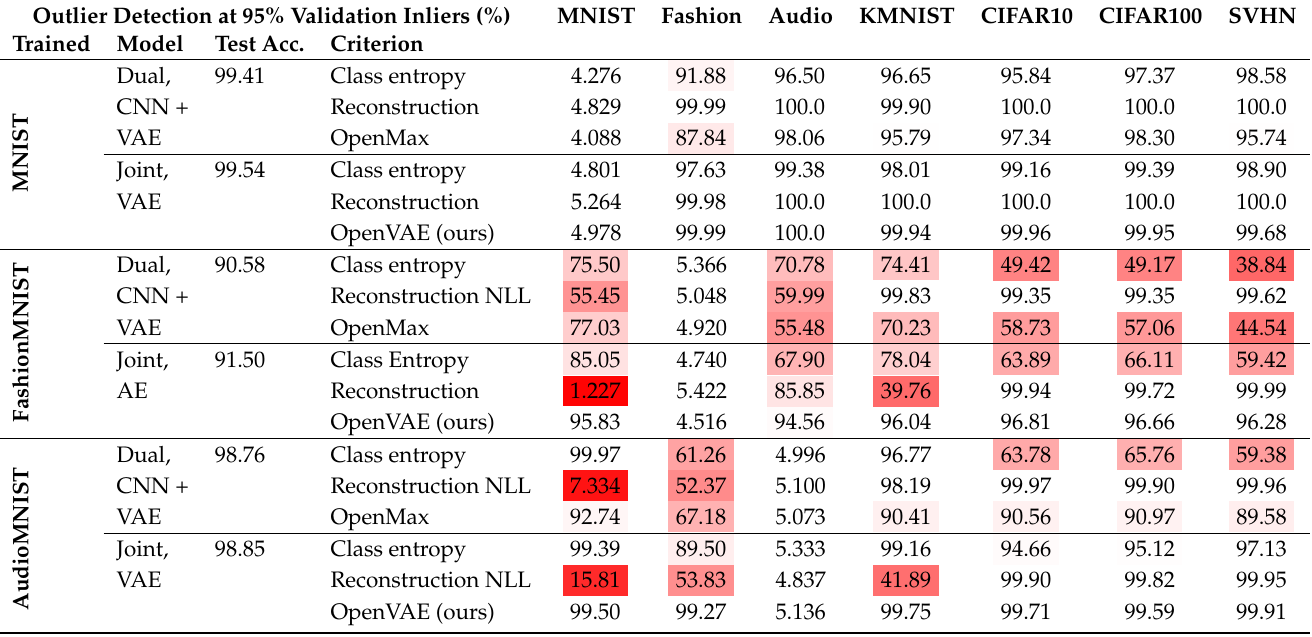
Table 2. Outlier detection values of the joint model and separate discriminative and generative models (denoted as “CNN + VAE”; discriminative convolutional neural network and variational auto-encoder), when considering 95% of known tasks’ validation data is inlying. The percentage of detected outliers is reported based on classifier predictive entropy, reconstruction negative log- likelihood (NLL) and our posterior-based EVT approach. In contrast to Table 1, the results are now averaged over 50 Monte-Carlo dropout samples, with p dropout = 0.2 for each layer, per data-point, respectively, to assess the model uncertainty. Note that larger values are better, except for the test data of the trained dataset, where ideally 0% should be considered as outlying. The color coding is analogous to Table